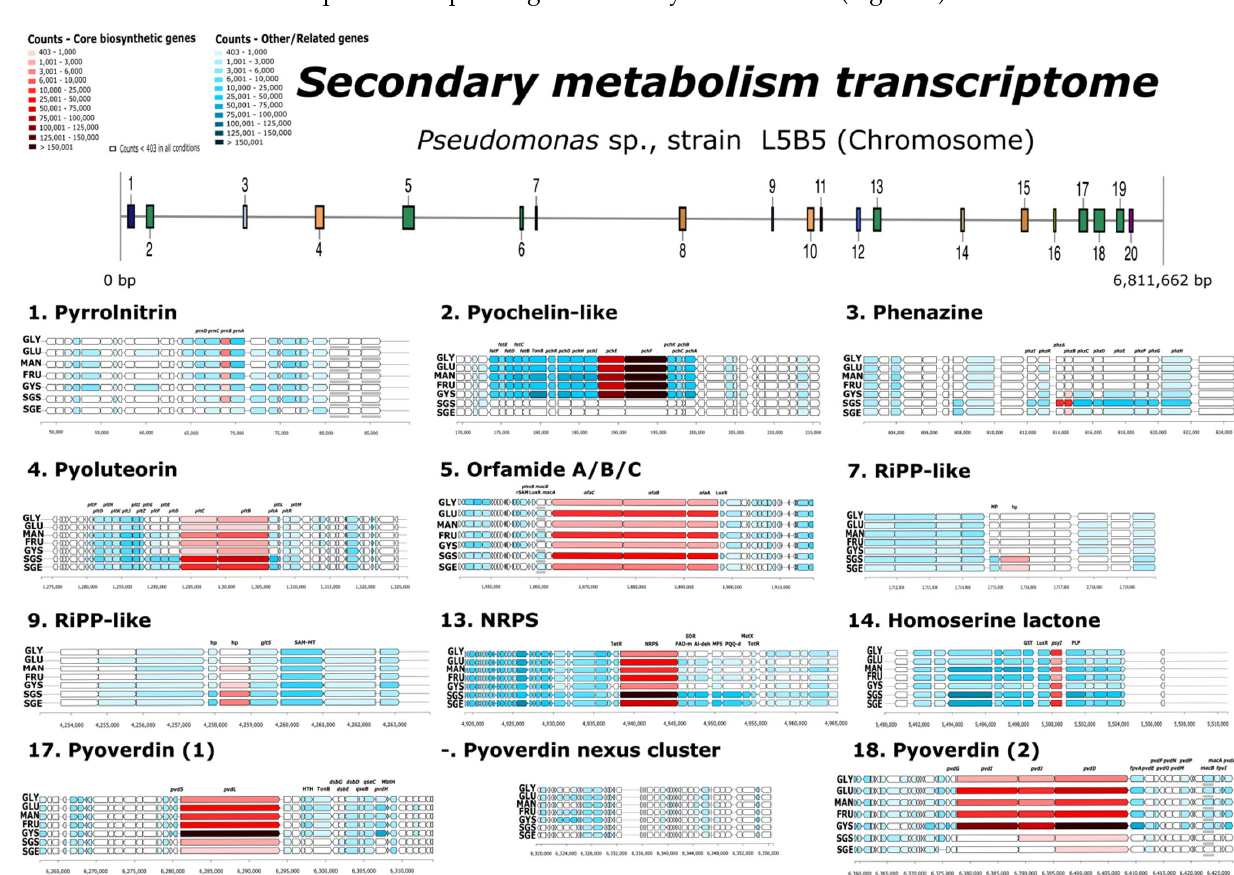
Figure 8. Heat map for secondary metabolism cluster predicted for Pseudomonas sp., strain L5B5 and overexpression of genes through RNA-seq analyses. GLY: RNA extracted from liquid culture (NB) supplemented with glycerol in stationary phase; GLU: RNA extracted from liquid culture (NB) supplemented with glucose in stationary phase; MAN: RNA extracted from liquid culture (NB) supplemented with mannose in stationary phase; FRU: RNA extracted from liquid culture (NB) supplemented with fructose in stationary phase; SGS: RNA extracted from solid culture (NA) supplemented with glycerol in stationary phase; SGE: RNA extracted from solid culture (NA) supplemented with glycerol in exponential phase.